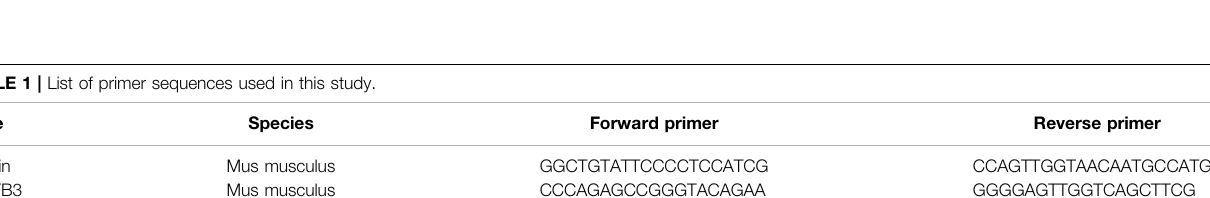
Frontiers in Pharmacology |